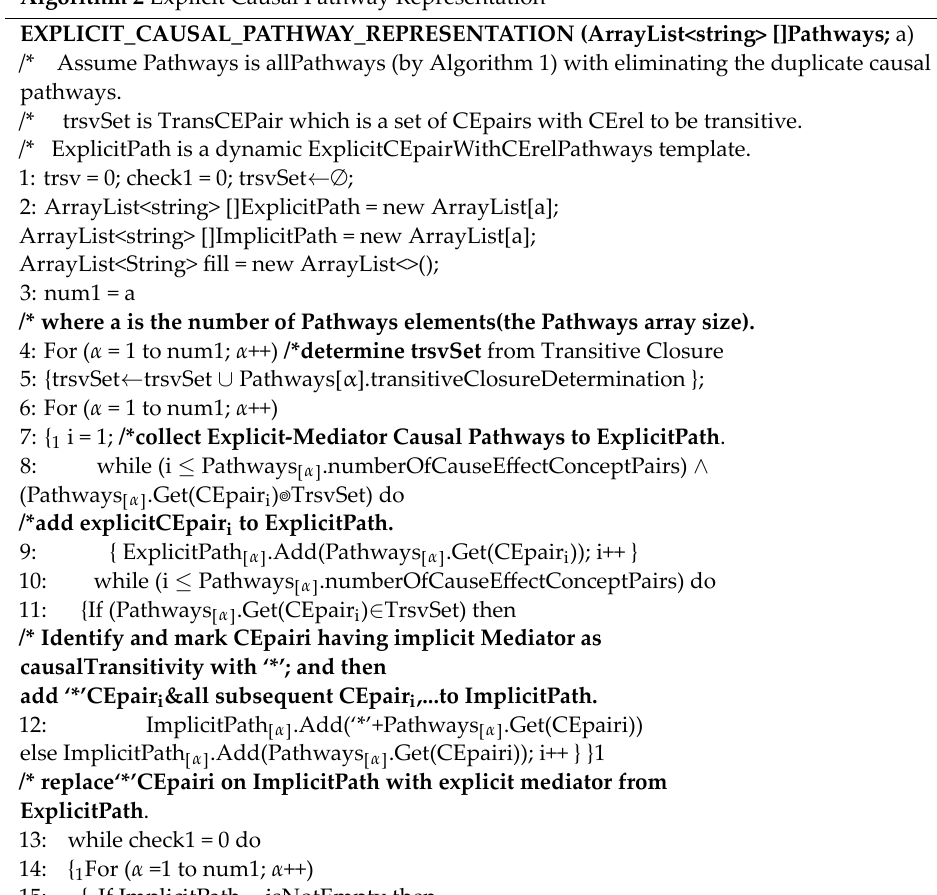
Algorithm 2 Explicit Causal Pathway